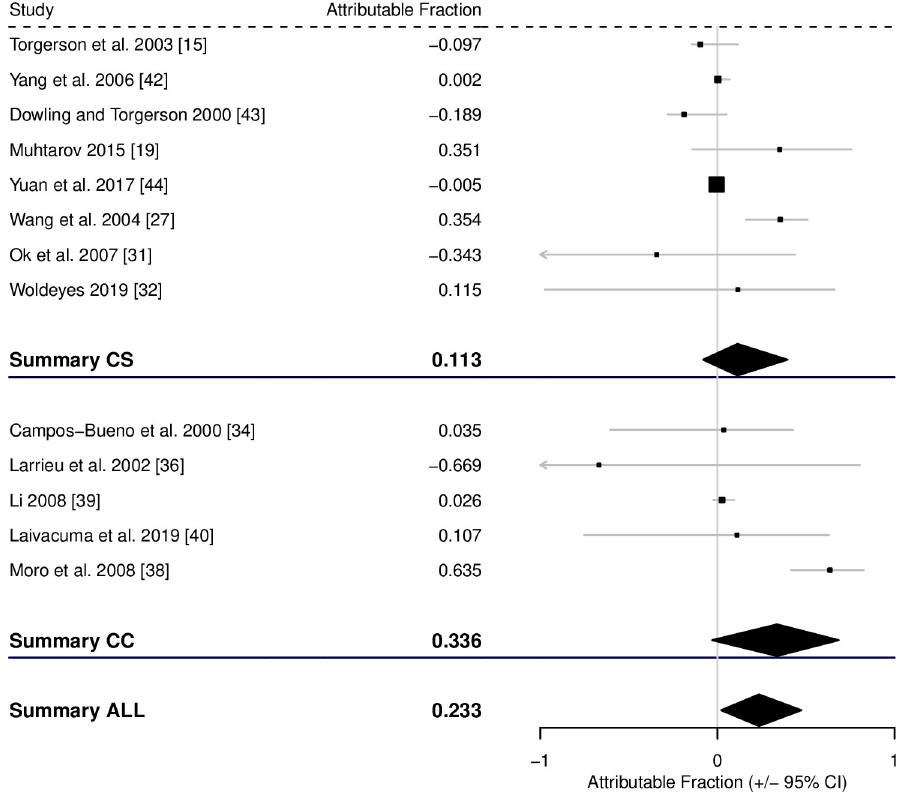
Fig 5. Forest plot for the attributable fraction for 8 cross-sectional studies and 5 case-control studies that analysed contaminated food as a potential risk factor for CE.